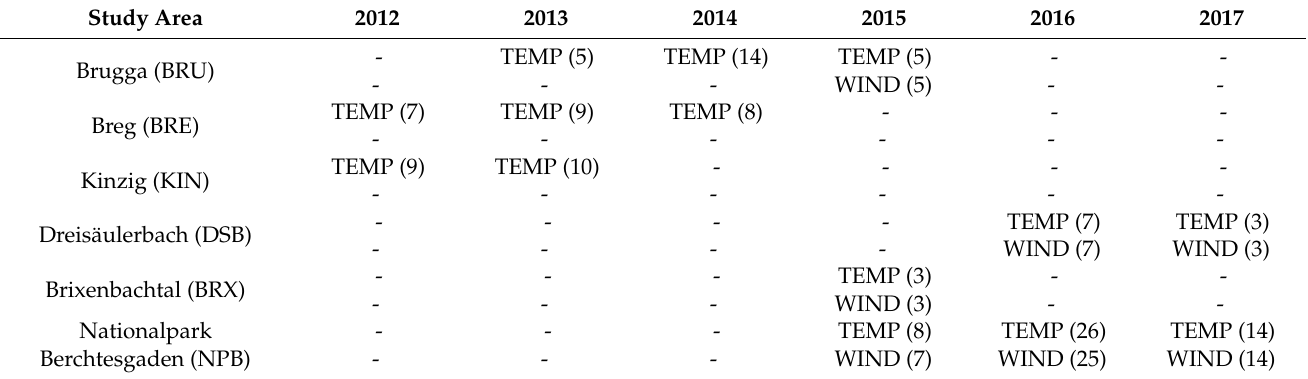
Table 1. Number of measurement stations separated by study area, year, and micrometeorological quantity. Study